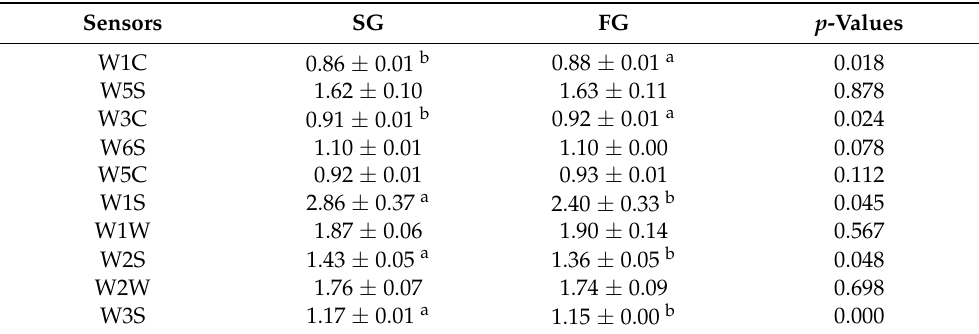
Figure 1. Electronic nose analysis of slow-growing and fast-growing (SG and FG) duck breast meat. ( A ) Radar chart of the E-nose in SG and FG meat. ( B ) The linear discriminant analysis (LDA) of the E-nose in SG and FG meat. Table 4. Comparison on typical response values of E-nose sensors (G/G0 ratio) from slow- and fast-growing duck